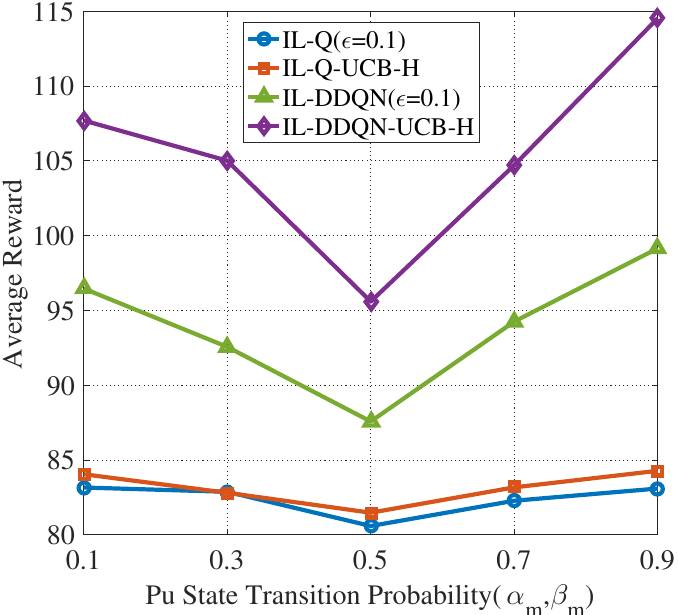
Figure 11. Evolution of the average reward of four algorithms with different PU state transition probabilities ( N = 4, M =